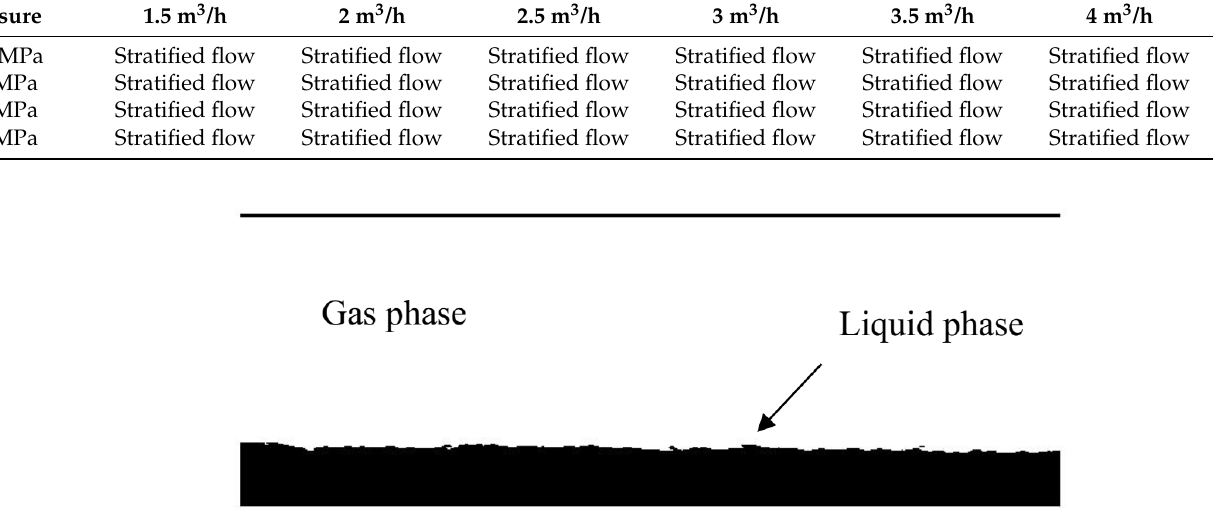
Figure 2. Image after image processing of stratified flow when the pressure is 0.15 MPa.